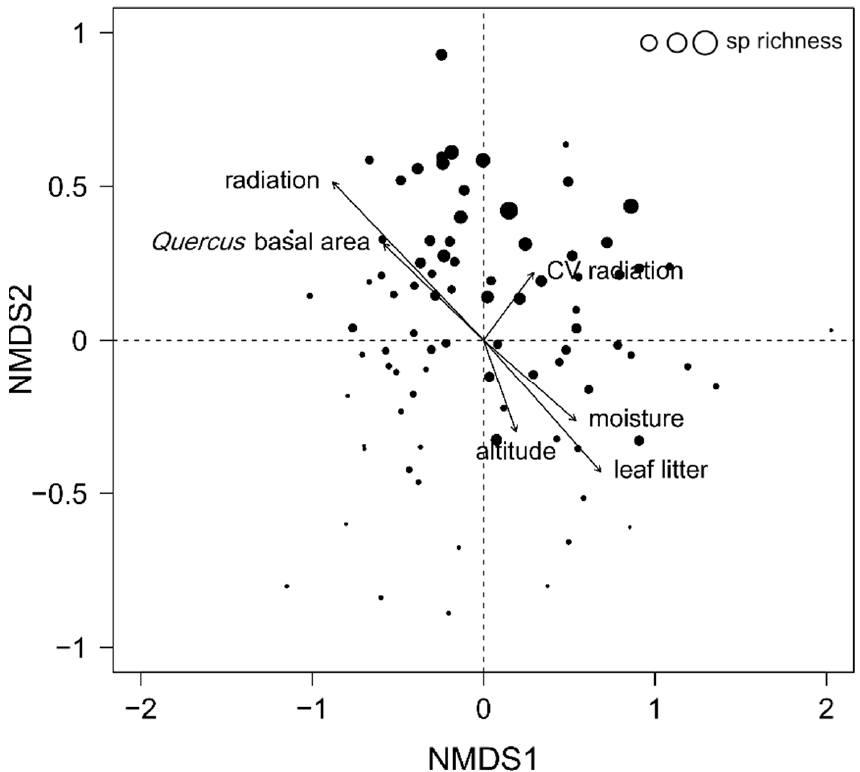
Figure 1. NMDS diagram of the herb-layer species composition (stress = 0.2; iterations = 95) and significant relationships between species composition and environmental variables such as altitude, leaf litter cover, moisture, radiation and its coefficient of variation (CV), and Quercus basal area (arrows). Other environmental variables were not significant. The length of each arrow indicates the correlation value. Circles represent each of the 86 plots of the basin, with size being proportional to the species